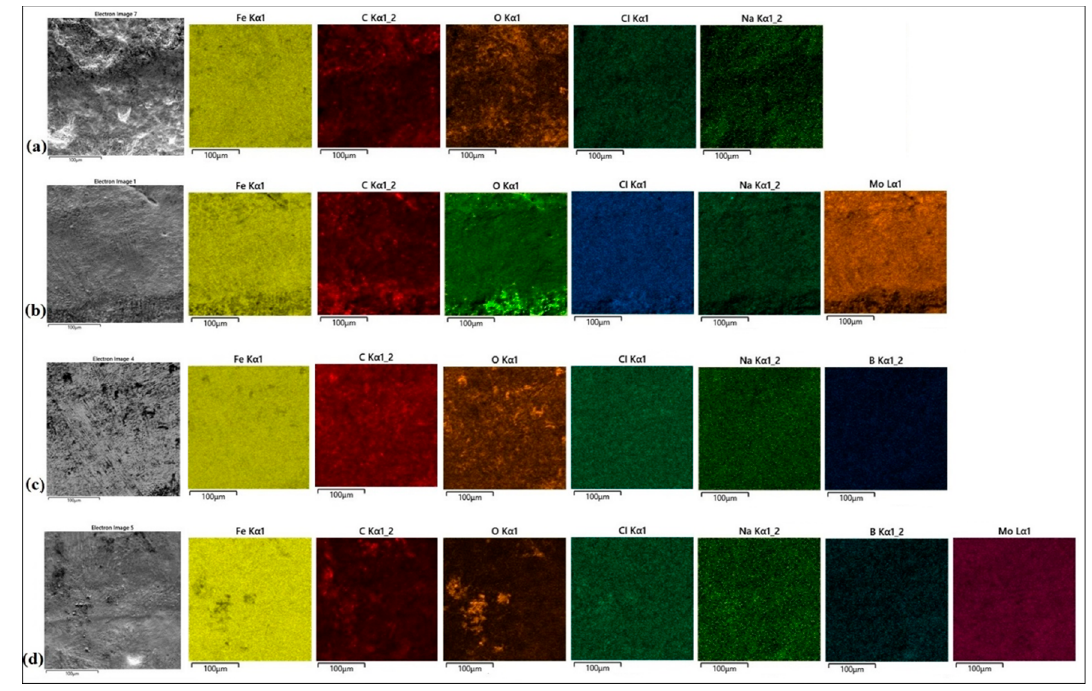
Figure 10. EDS mapping of surface condition after laser alloying and corrosion tests: ( a ) CT90 steel; ( b ) Mo coating; ( c ) B coating; ( d ) Mo-B coating.